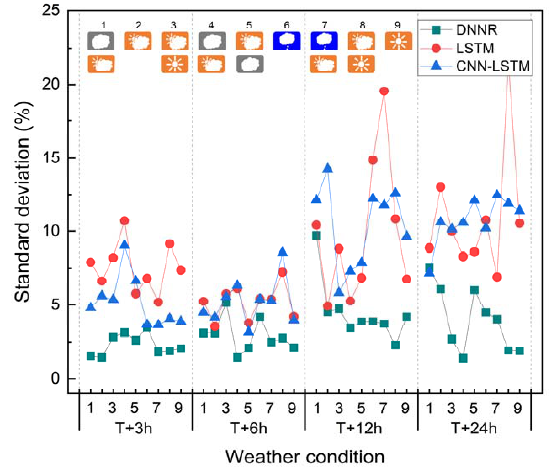
Figure 17. Statistics of the error distribution between the predicted value of the best model and the actual value for Greenhouse B humidity. The errors of the three models errors under different weather conditions are shown in Figure 18, for three models, the ST of DNNR model is the smallest under different weather conditions, and the ST of three models increase with the training set time horizon, the ST of three models are the biggest at T+12 time point under different weather condi ‐ tions, which means that the DNNR is the best predictive model among the three models, and the DNNR model is not suitable for prediction of parameters 12 h ahead.